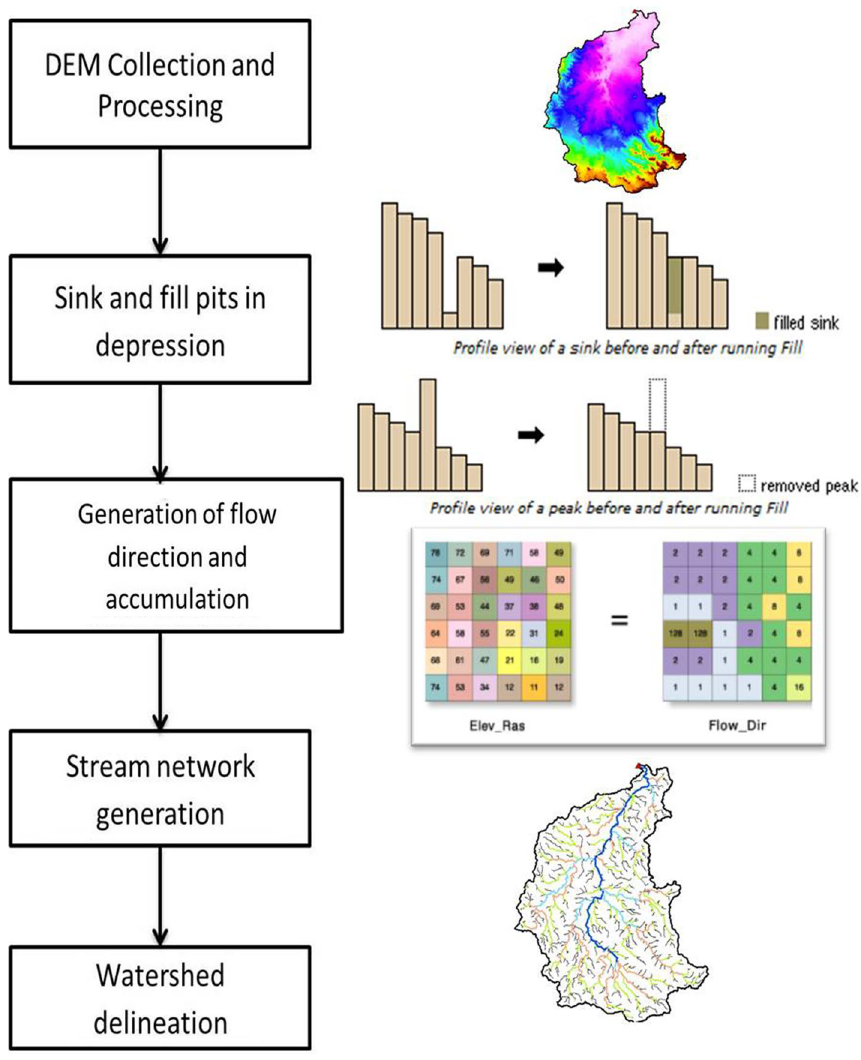
Fig. 2 Watershed delinea- tion process using ArcGIS arc